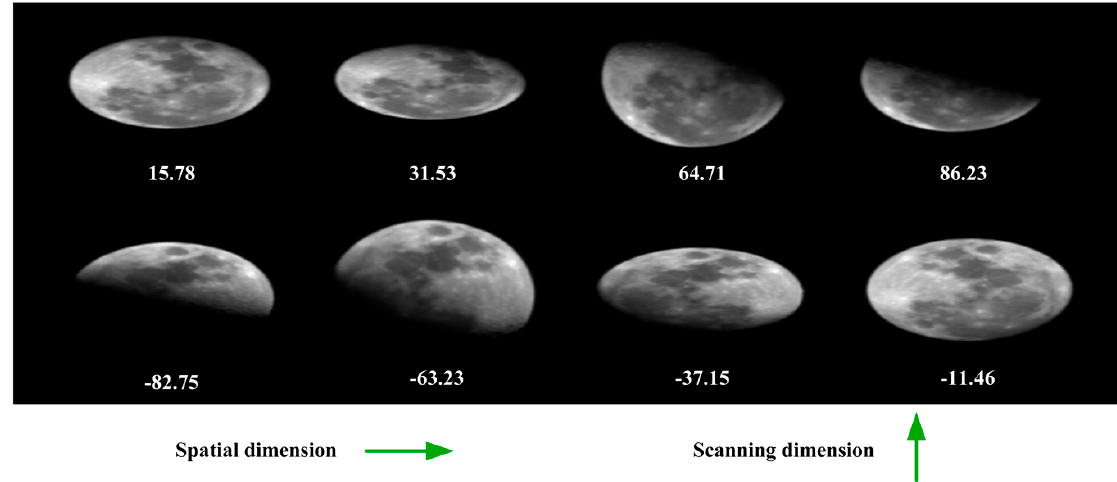
Figure 4. Lunar images at 550 nm in different lunar phases.